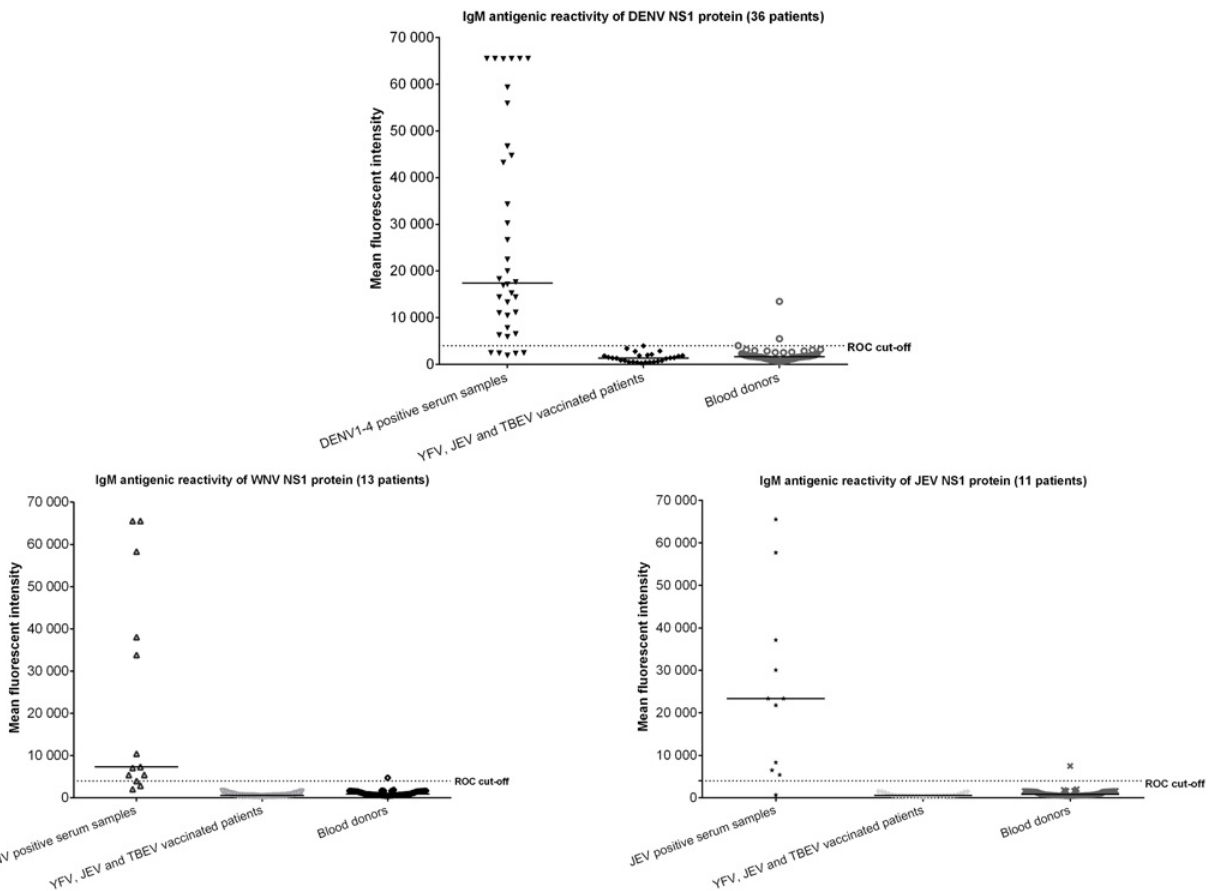
Fig 3. IgM fluorescent intensity (measured at 647nm) to flaviviruses in serum samples from clinical patients, persons vaccinated with YFV, JEV or TBEV and healthy blood donors in a 1:20 serum dilution. NS1 proteins were spotted in a 0,5mg/ml concentration. Y axis represents the fluorescent intensity. The median signal is depicted as a line. The dotted line represents the calculated cut-off by the ROC used to determine antibody titers.